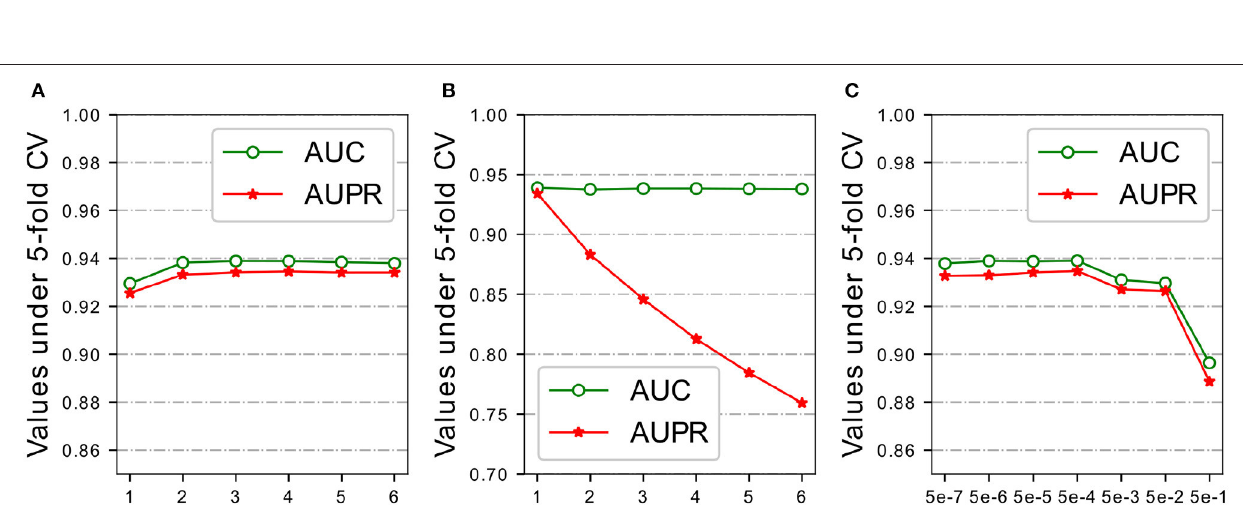
FIGURE 3 | Parameters analysis of DeepWalk and GAT on HMDD v2.0 dataset. (A) Window size Weight DeepWalk. (B) Feature size Weight DeepWalk. (C) # heads of GAT. (D) # layers of GAT.